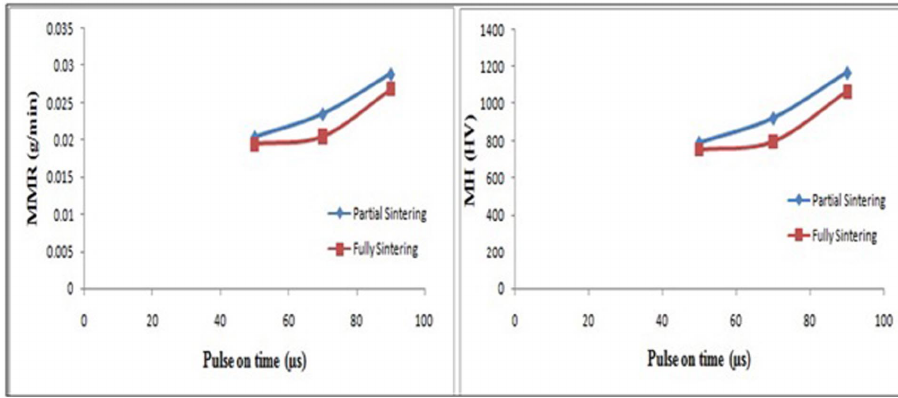
Figure 7: Effect of pulse on time on MMR and MH